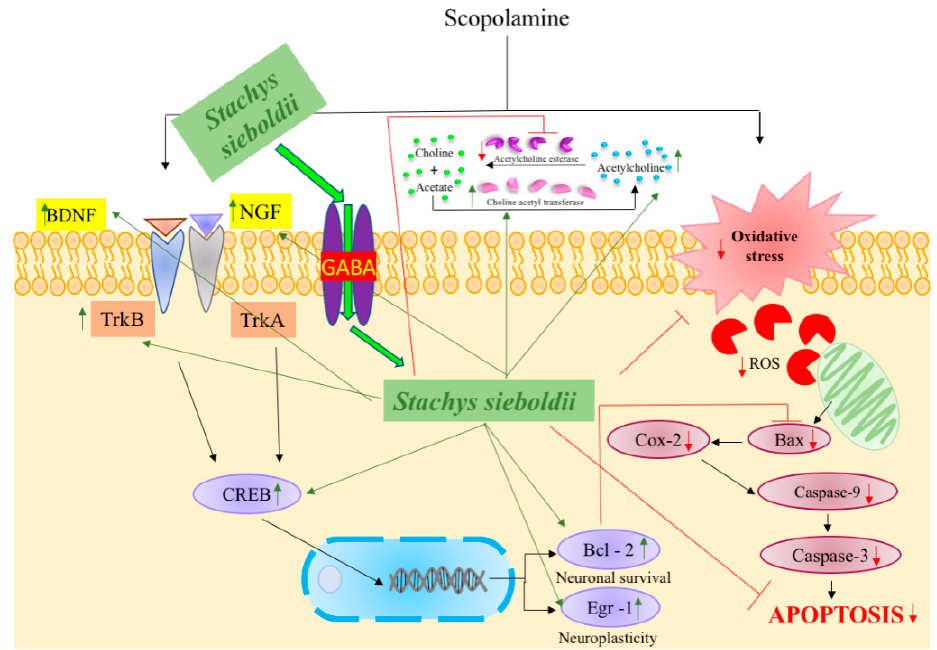
Figure 9. Mechanisms underlying the effects of Stachys sieboldii (SS). SS downregulated cellular apoptosis signaling cascade such as Bax, COX-2, Caspase-9 and Caspase-3, which results in